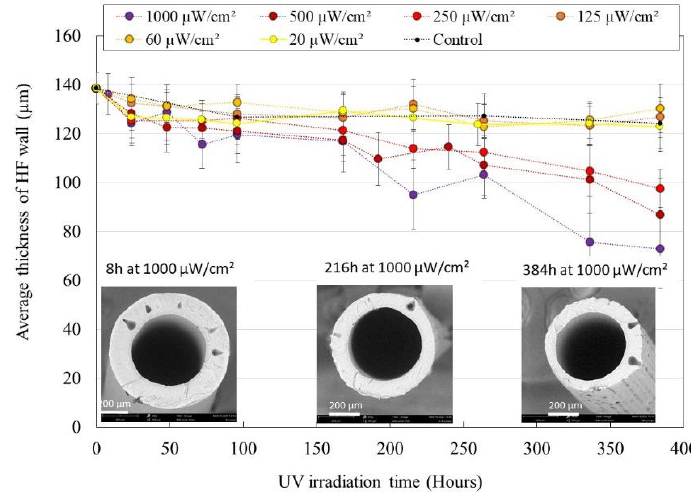
Figure 1. Average thickness of HFs’ wall after UV irradiation in UP water with various irradiation powers. Insert: SEM images of HFs irradiated at 1000 µW/cm² during 8 h, 216 h or 384 h (×350 magnification).